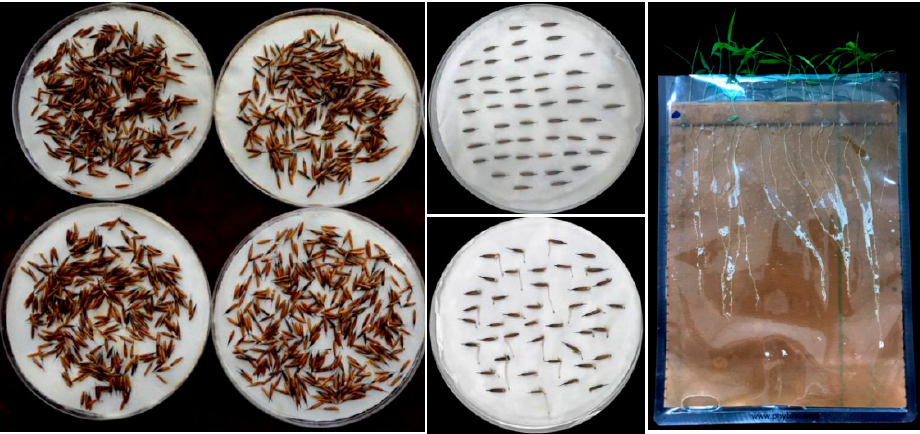
Figure 1. Cultivation of P. edulis sprouting seedlings.